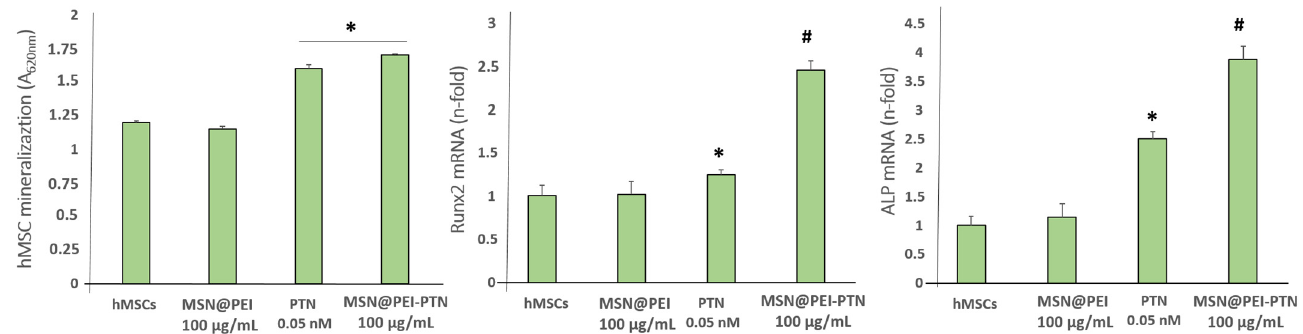
Figure 8. Mineralization and changes in osteoblastic gene expression in human Mesenchymal Stem Cells (hMSC) induced by different nanosystems loaded or not with pleiotrophin (PTN) or in the presence of 0.05 nM exogenous PTN alone. Mineralization was assessed using alizarin-red staining at day 15. The gene expression of Runx2 and ALP markers (analyzed by real time PCR) was measured at day 5. Data are mean ± SEM of three independent experiments performed in triplicate. * p < 0.05 vs. MSN 100 µ g/mL; # p < 0.01 vs. PTN 0.05 nM and all groups.